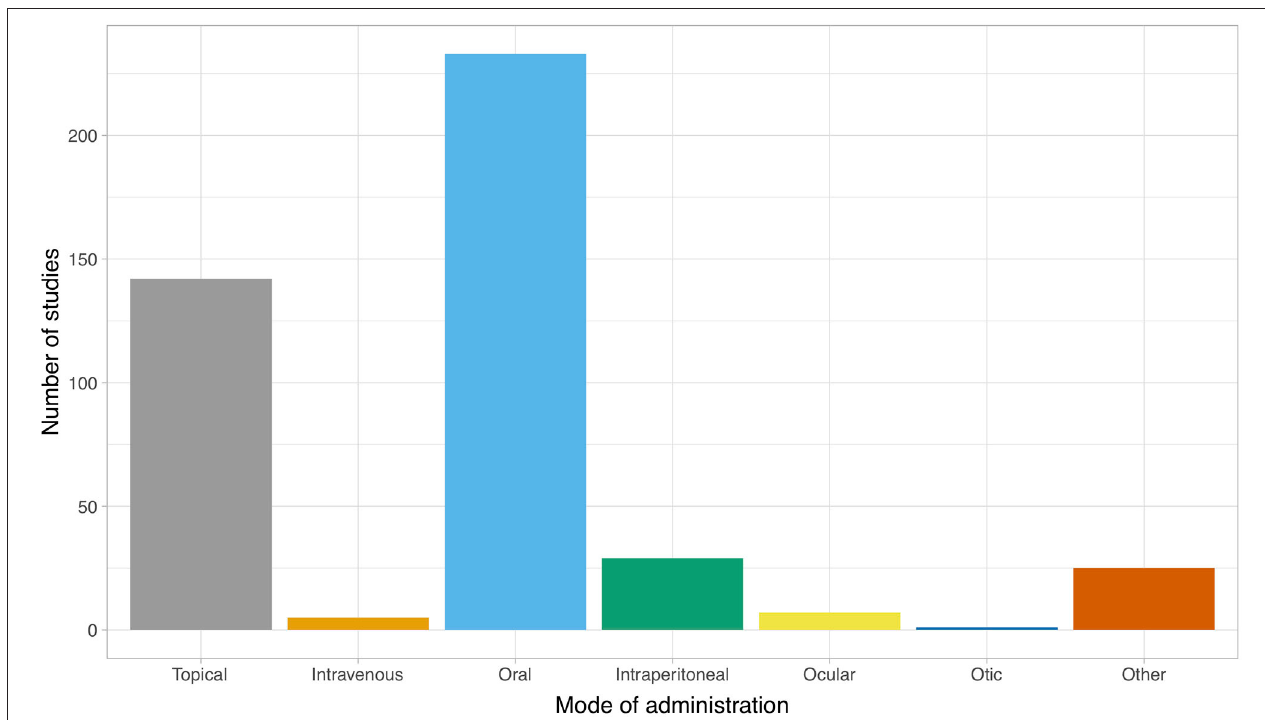
FIGURE 4 | Mode of administration of the intervention for publications ( n = 397) included in a scoping review of the evidence for the medicinal use of natural honey in animals. Data are presented at the study level. The total count exceeds 397 since some publications reported several studies, and some studies reported more than one mode of